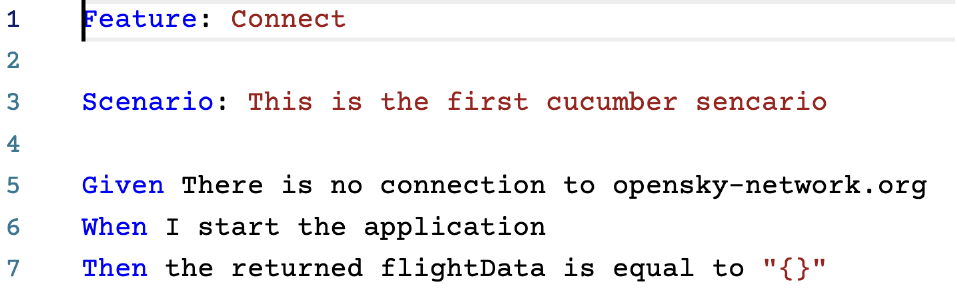
Figure 3. Simple test written in